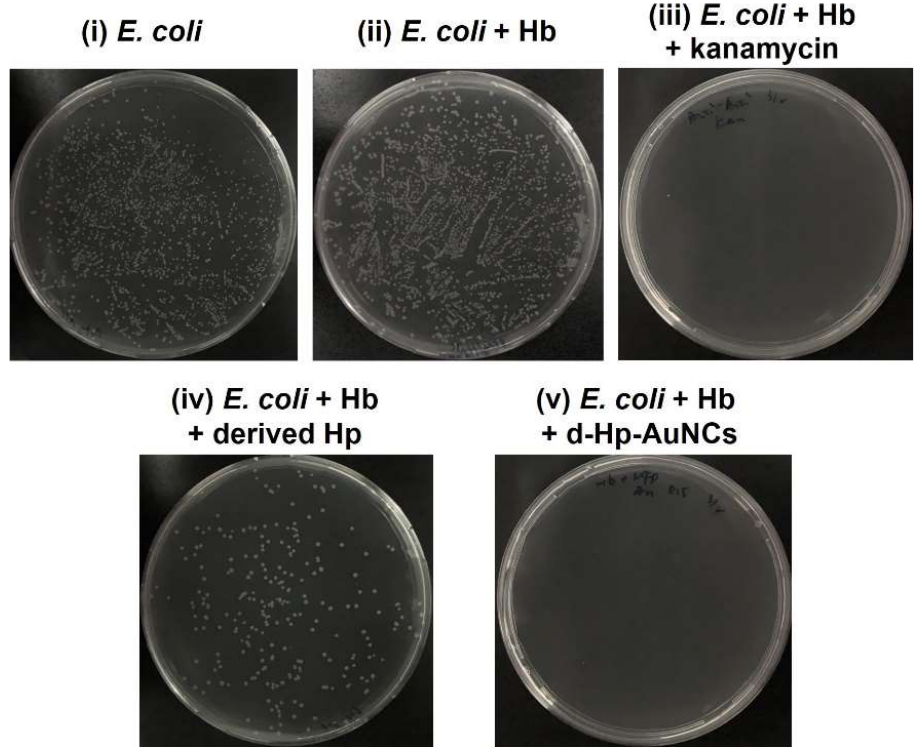
Figure 5. Photographs of the growth of Escherichia coli in five different bacterial solutions, including ( i ) E. coli , ( ii ) E. coli + hemoglobin (Hb), ( iii ) E. coli + Hb + kanamycin, ( iv ) E. coli + Hb + derived haptoglobin (d-Hp), and ( v ) E. coli + Hb + d-Hp-gold nanoclusters (AuNCs).